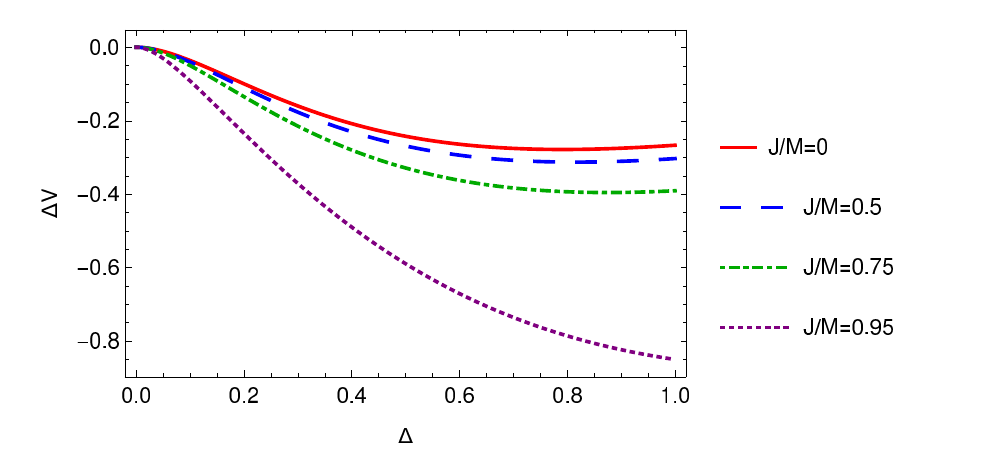
Figure 5 . Average null energy for di(cid:11)erent values of the conformal dimension (cid:1) at (cid:12)xed temper- ature T = 1 . 2 (cid:25)